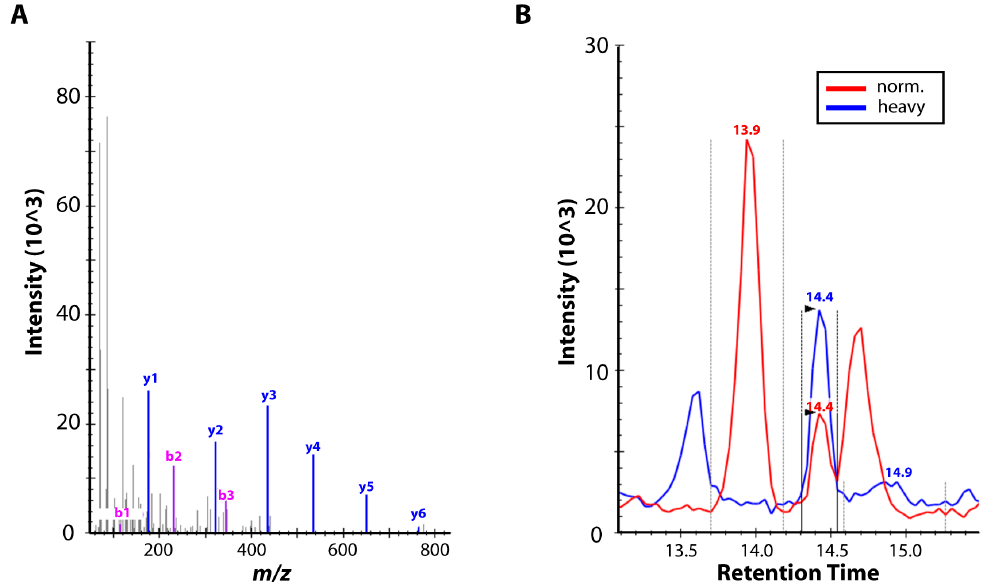
Figure 4. Mass spectrometric (MS) proteomic analysis. ( A ) Representative MS/MS spectrum of variola virus-specific peptide (NDDVLFR) from sample V1588. The spectrum depicts the intensity ( y -axis) of analyzed mass-to-charge ratios of identified peptide fragments ( x -axis). Based on this spectrum, fragments y4, y5 and y6 were involved in the Selected Reaction Monitoring (SRM) technique. ( B ) Selected Reaction Monitoring chromatogram of peptide (NDDVLFR) of sample V563. The peptide digest (in red) was analyzed with spiked synthetic, heavy-labeled counterpart (in blue). The presence of both peaks at a retention time of 14.4 min (based on prior heavy peptide analysis) together with the consistency of intensities of the ion pairs is an unambiguous evidence of the presence of peptide (NDDVLFR).